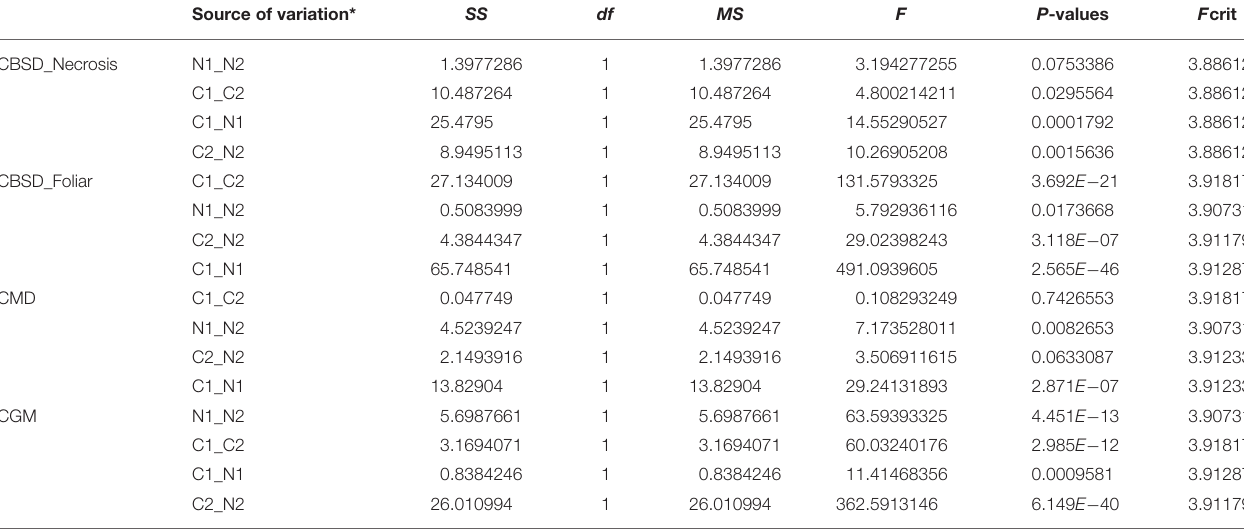
TABLE 2 | Analysis of variance (ANOVA) across sites and